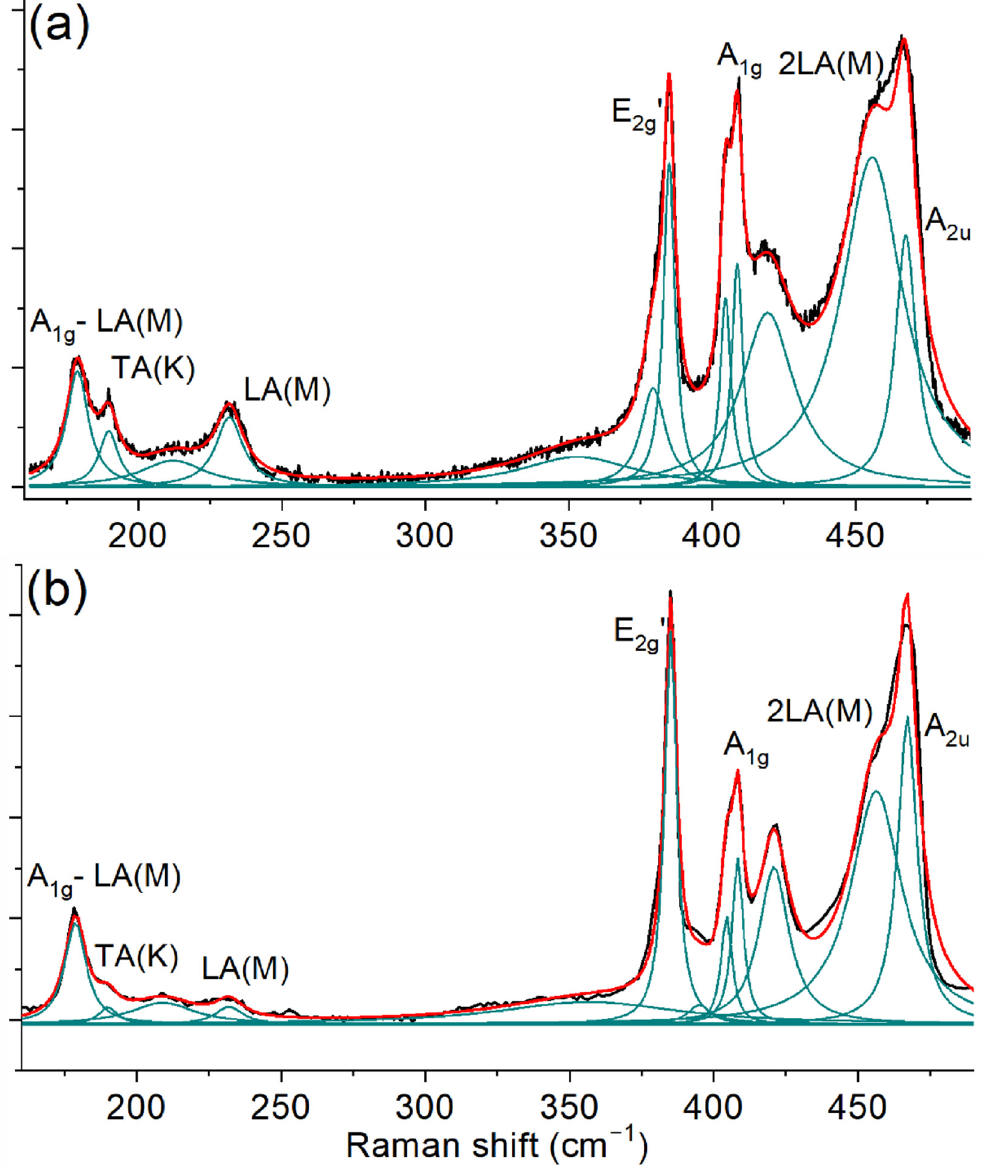
Figure 5. Raman spectra of MoS 2 : ( a ) Sulfurized MoO 3 film; ( b ) exfoliated reference flake.